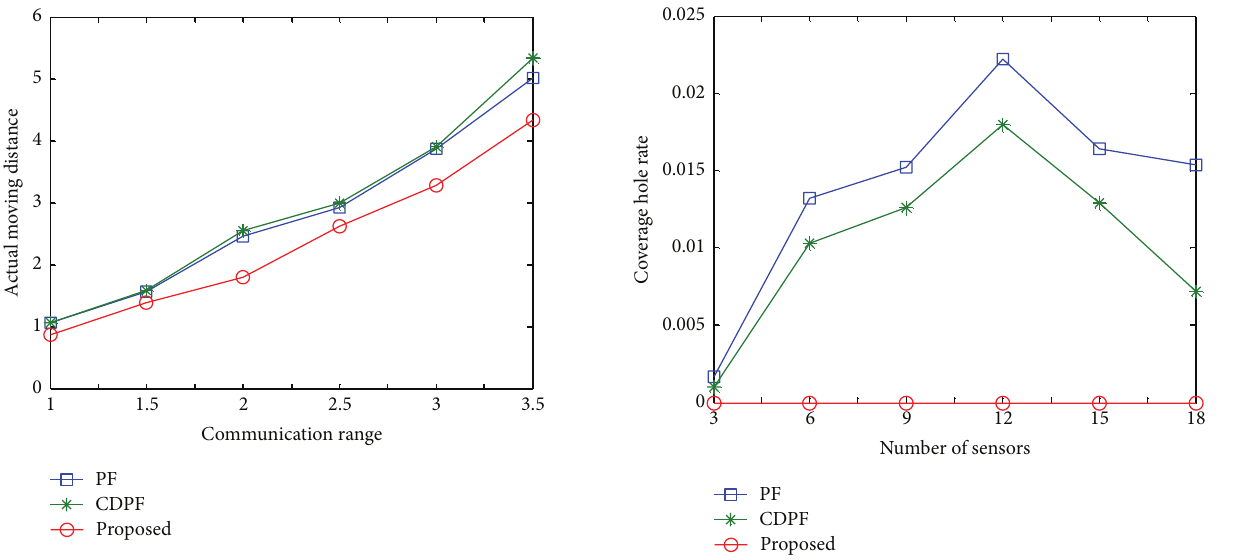
Figure 6: Actual moving distance versus communication range /𝑟 ) . (𝑟 𝑐 𝑠